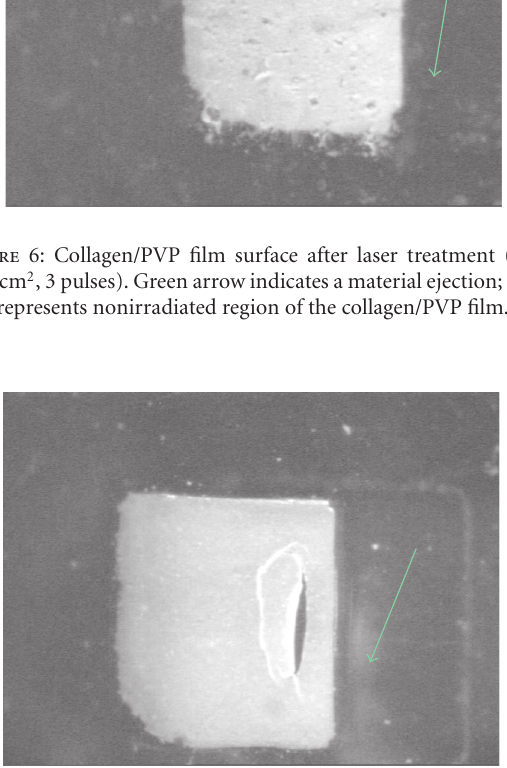
Figure 5: Collagen/PVP film surface after laser treatment ( F = 0 . 7 J/cm 2 , 15 pulses). Green arrows indicate a material ejection; black area represents nonirradiated region of the collagen/PVP film.